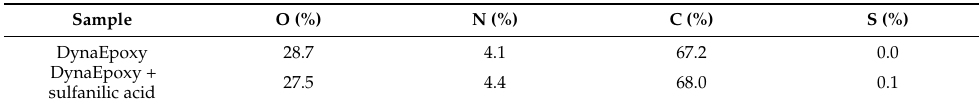
Table 6. Elemental composition (%) determined by XPS analysis. The error does not exceed the 1–2% of the reported value.